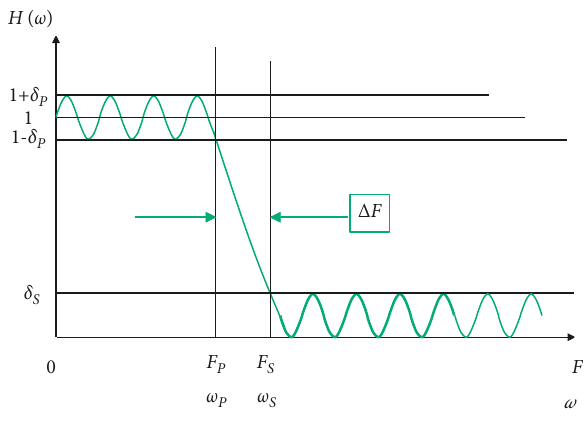
Figure 5: Spectrogram of the filter.